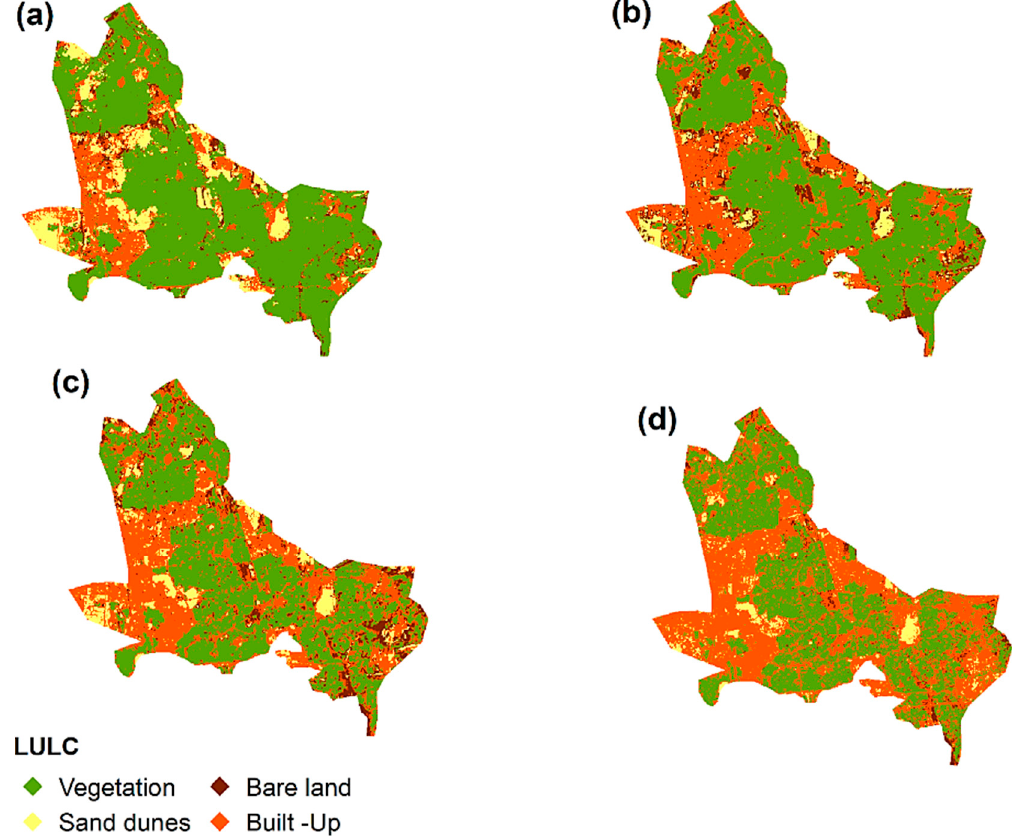
Figure 3. Classified images of LULC types: ( a ) 1990, ( b ) 2000, ( c ) 2010, and ( d ) 2020. Table 2. Accuracy assessment of LULC classification results for the study area from 1990 to 2020.